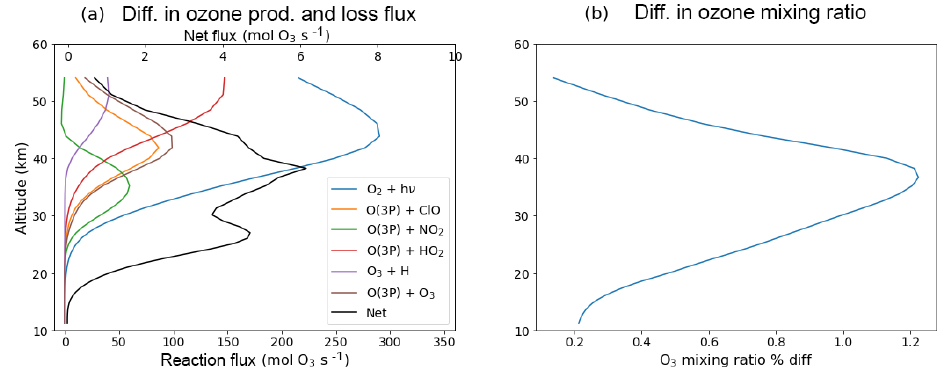
Figure 3. Difference in the (a) chemical flux of the ozone production and loss reactions and (b) global mean ozone mixing ratio between the control and solar cycle runs for